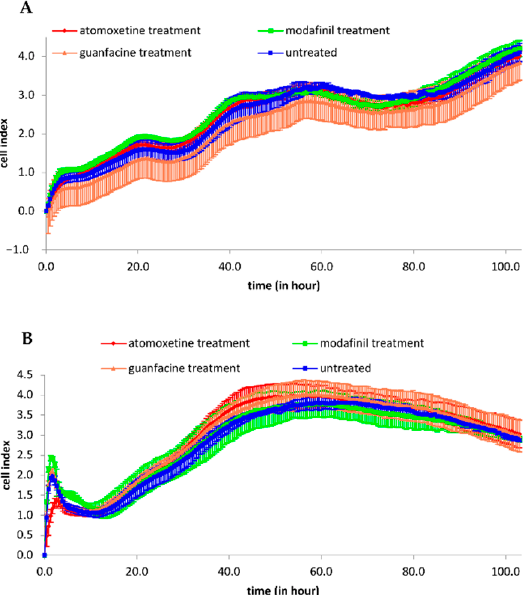
Figure 1. XCELLigence analysis of real-time cell proliferation of untreated MG63 ( A ), untreated hMSC ( B ) and after the administration of modafinil (11.2 µg/mL), atomoxetine (0.9 µg/mL) and guanfacine (17.7 ng/mL) to hMSC and MG63 for 100 h. Shown are means of normalized cell index ± SD of three independent experiments with six biological replicates.